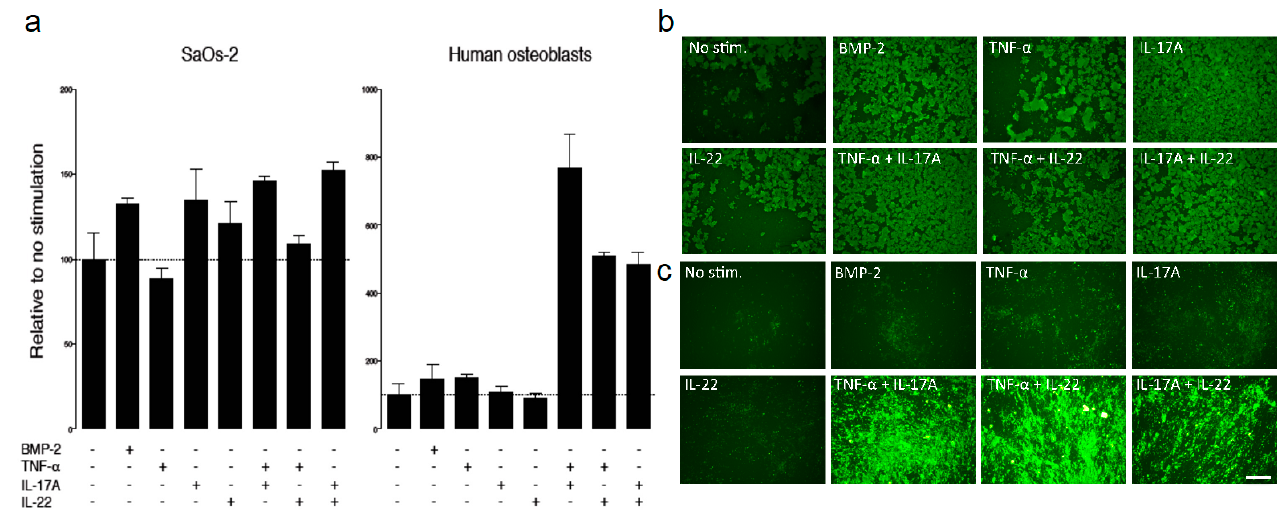
Figure 4. Bone mineralization of osteogenic cells depends on protein interplay. ( a ) SaOs-2 and human osteoblasts were cultured with different protein families such as BMP-2, TNF- α , IL-17A, and Il-22. Vertical axes represent relative to no stimulation. Horizontal axes represent different protein stimulation of SaOs-2 and human osteoblasts. The interplay of proteins displays the highest expression. ( b , c ) Visualization of bone mineralization under cytokine stimulation. ( b ) SaOs-2 cells and ( c ) human osteoblasts. All values are relative to the control cell with no stimulation (No stim). Scale bar 250 µ